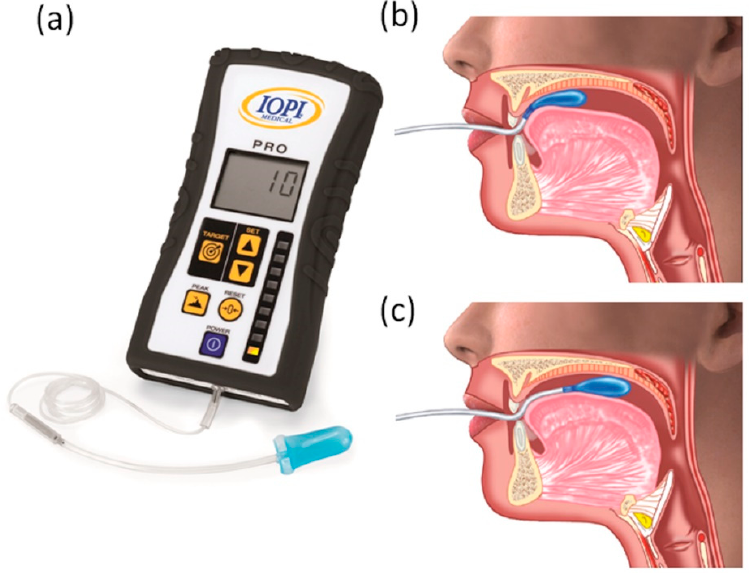
Figure 1. Iowa Oral Performance Instrument (IOPI). ( a ) An air-filled pliable plastic tongue bulb is connected through a clear plastic tube to the IOPI device, which displays the pressure measured. The tongue bulb can be positioned against the patient’s hard palate, just behind the alveolar ridge, ( b ) or at the transition between the hard and soft palate ( c ). The tongue compresses the bulb against the roof of the mouth, and the pressures exerted are measured and displayed on the IOPI LCD screen. Reproduced with permission from IOPI Medical LLC.